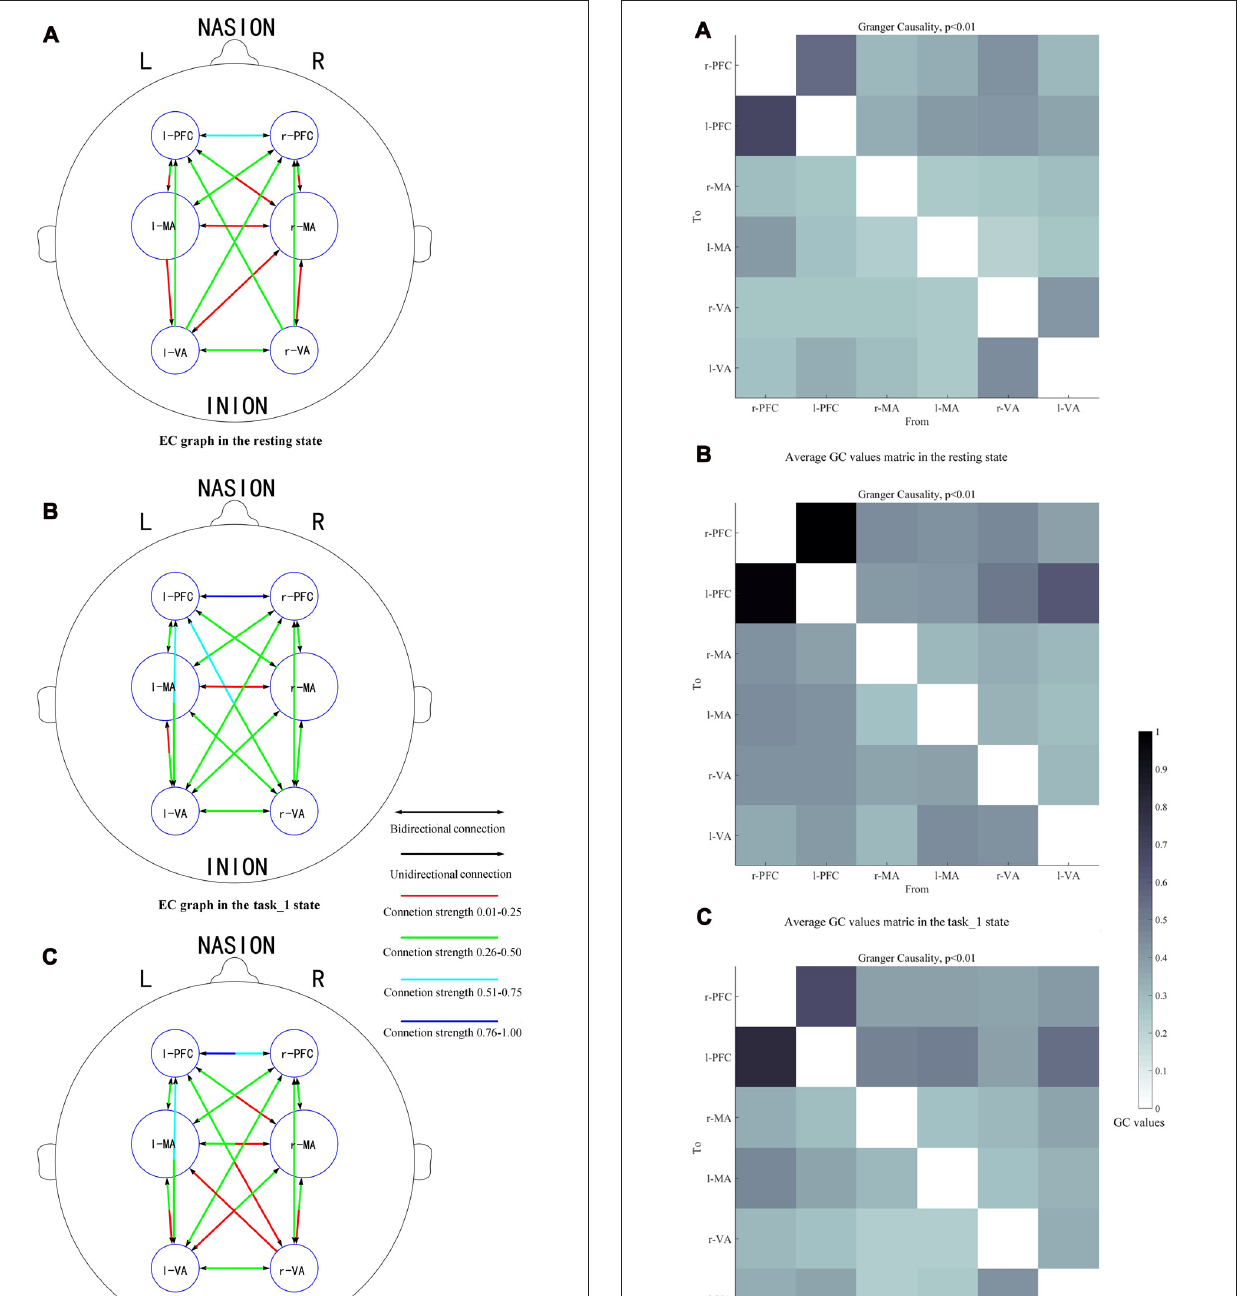
Frontiers in Behavioral Neuroscience |